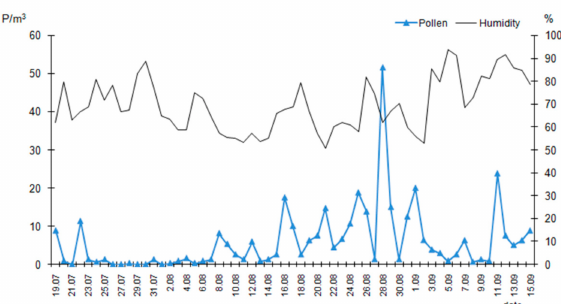
Figure 7. Course of the Ambrosia pollen season in Ivano-Frankivsk in 2015 versus the relative air humidity.